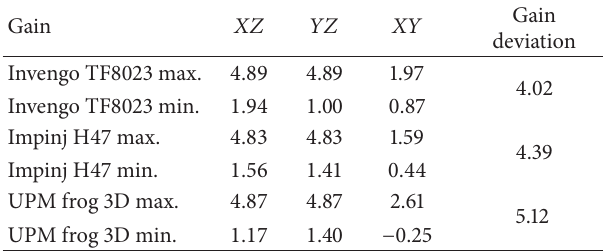
Table 4: Simulated gain values of the three commercial tag antennas in three planes (Unit: